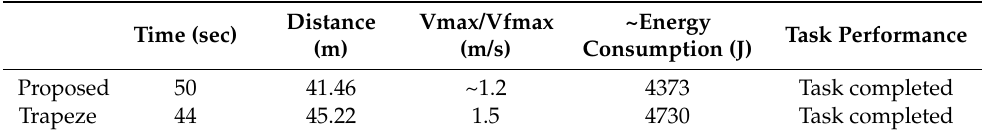
Table 2. Task motion analysis with the proposed method.